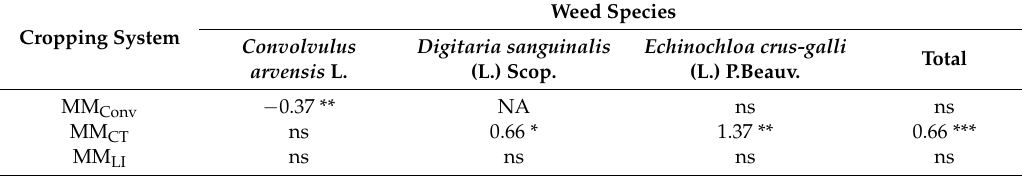
Table 2. Evolution of the potential of infestation (PI, log10 transformed) with time (5 years of experiment) for each weed species in each cropping system (10 observations for each system over the 5-year experiment; MM Conv : conventional maize monoculture; MM CT : conservation tillage maize monoculture; MM LI : low-input maize monoculture). Values represent the slope between time and weed species’ PI (log10 transformed) in the different cropping systems. Block was treated as a random factor. Slopes were tested to significantly different from zero (* p < 0.05, ** p < 0.01, *** p < 0.001, NA: not applicable, ns: not significant). Weed Species Cropping System Convolvulus Digitaria sanguinalis Echinochloa crus-galli arvensis L. (L.) Scop. (L.)